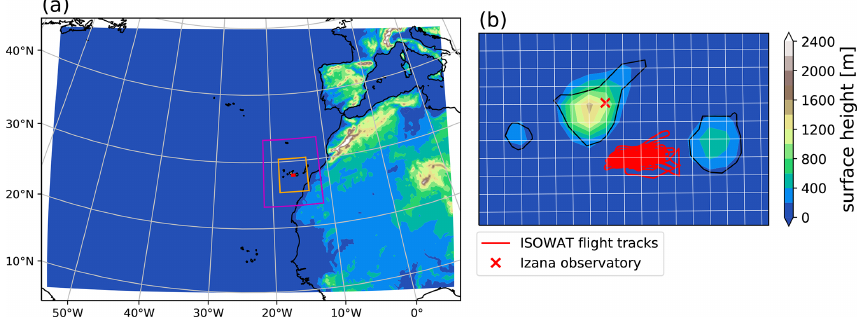
Figure 1. (a) COSMO iso model domain and topography. The orange box indicates the sampling area for the uncertainty estimation used for the comparison between COSMO iso and airborne in situ water vapour isotope data. The magenta box represents the sampling area of the satellite-based IASI remote sensing observations of stable isotopes in water vapour. (b) Enlarged view of the Canary Islands. The red lines depict the flight tracks of the summer 2013 MUSICA aircraft campaign and the red cross shows the location of the Izaña observatory on Tenerife, where the Fourier transform infrared (FTIR) spectrometer is installed for the ground-based remote sensing. The white lines represent the COSMO iso grid with a horizontal resolution of 0.125 ◦ ( ∼